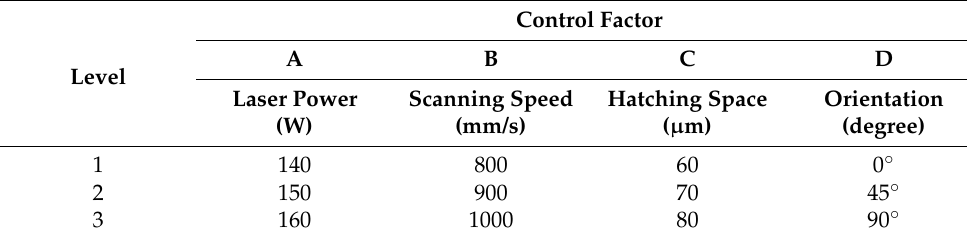
Table 1. Control factors and their levels in LPBF